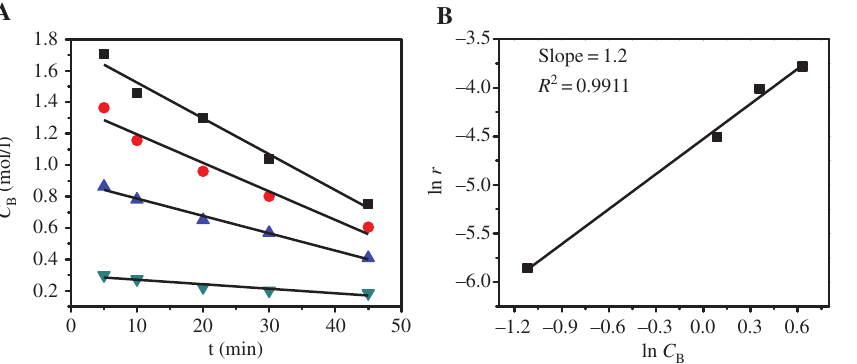
O concentration ( C ) versus reaction time; symbols for initial C 2 2 B